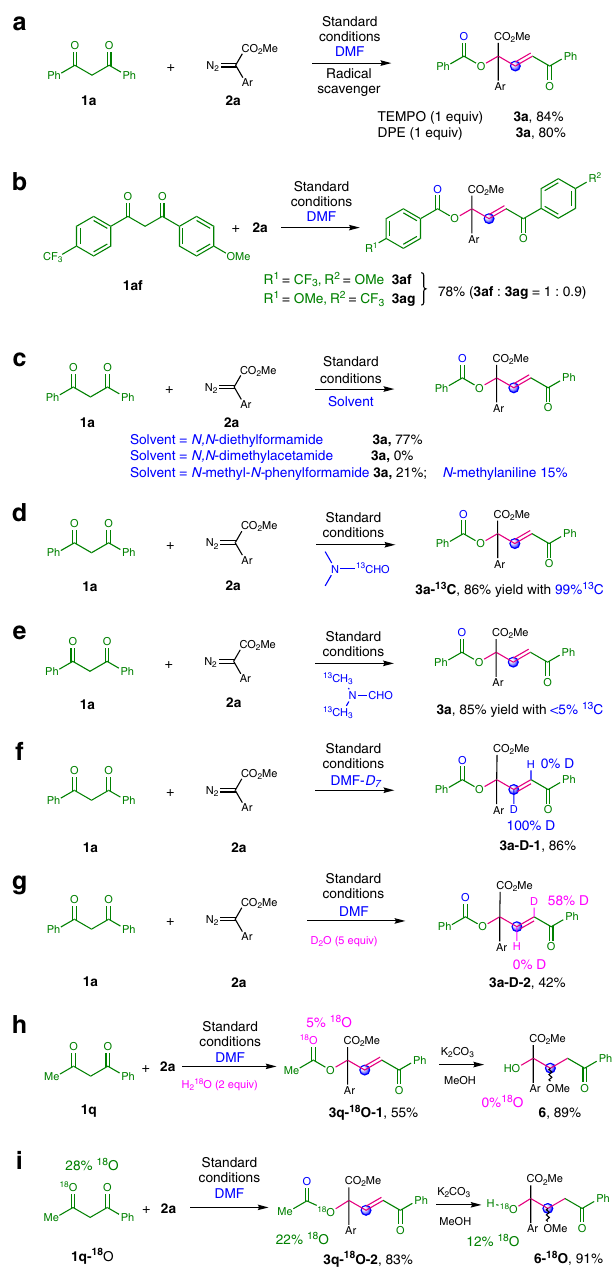
Fig. 4 Control experiments and isotope-labeling reactions. a Radical trapping experiments. b The reaction of unsymmetrical 1,3-dione. c The reactions using other amide solvents. d 13 C-labeled experiment using DMF- formyl- 13 C as solvent. e 13 C-labeled experiment using DMF-dimethyl- 13 C 2 as solvent. f Deuterium-labeling experiments using DMF- D7 as solvent. g Deuterium-labeling experiments in the presence of D 2 O. h 18 O-labeled experiment in the presence of H 2 18 O. i The reactions of 18 O-labeled 1,3-dione.